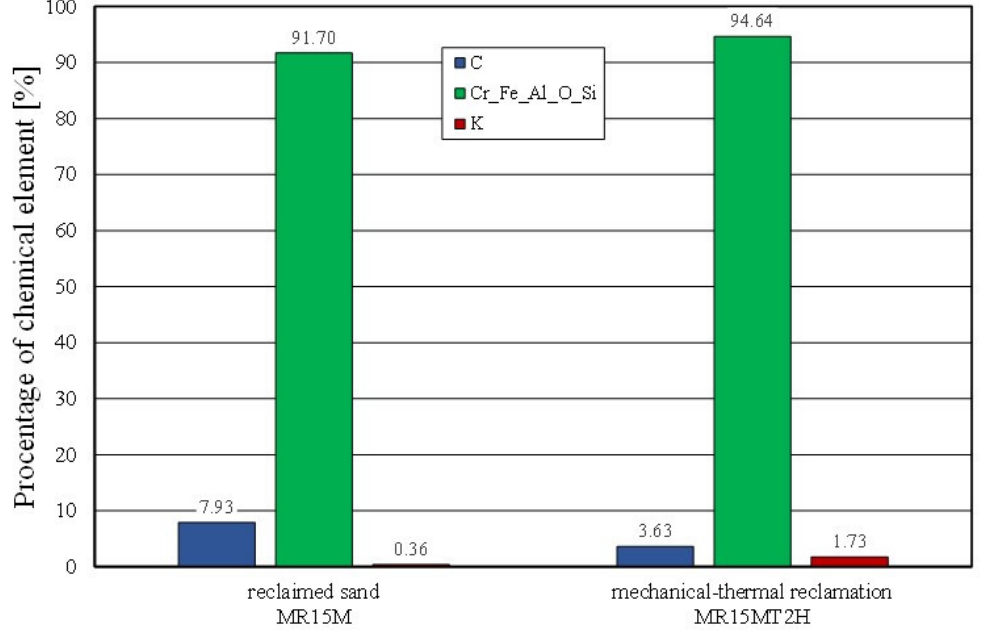
Figure 20. Comparison of chemical compositions of grain matrix after 15 min mechanical reclamation and grain matrix after mechanical–thermal reclamation.